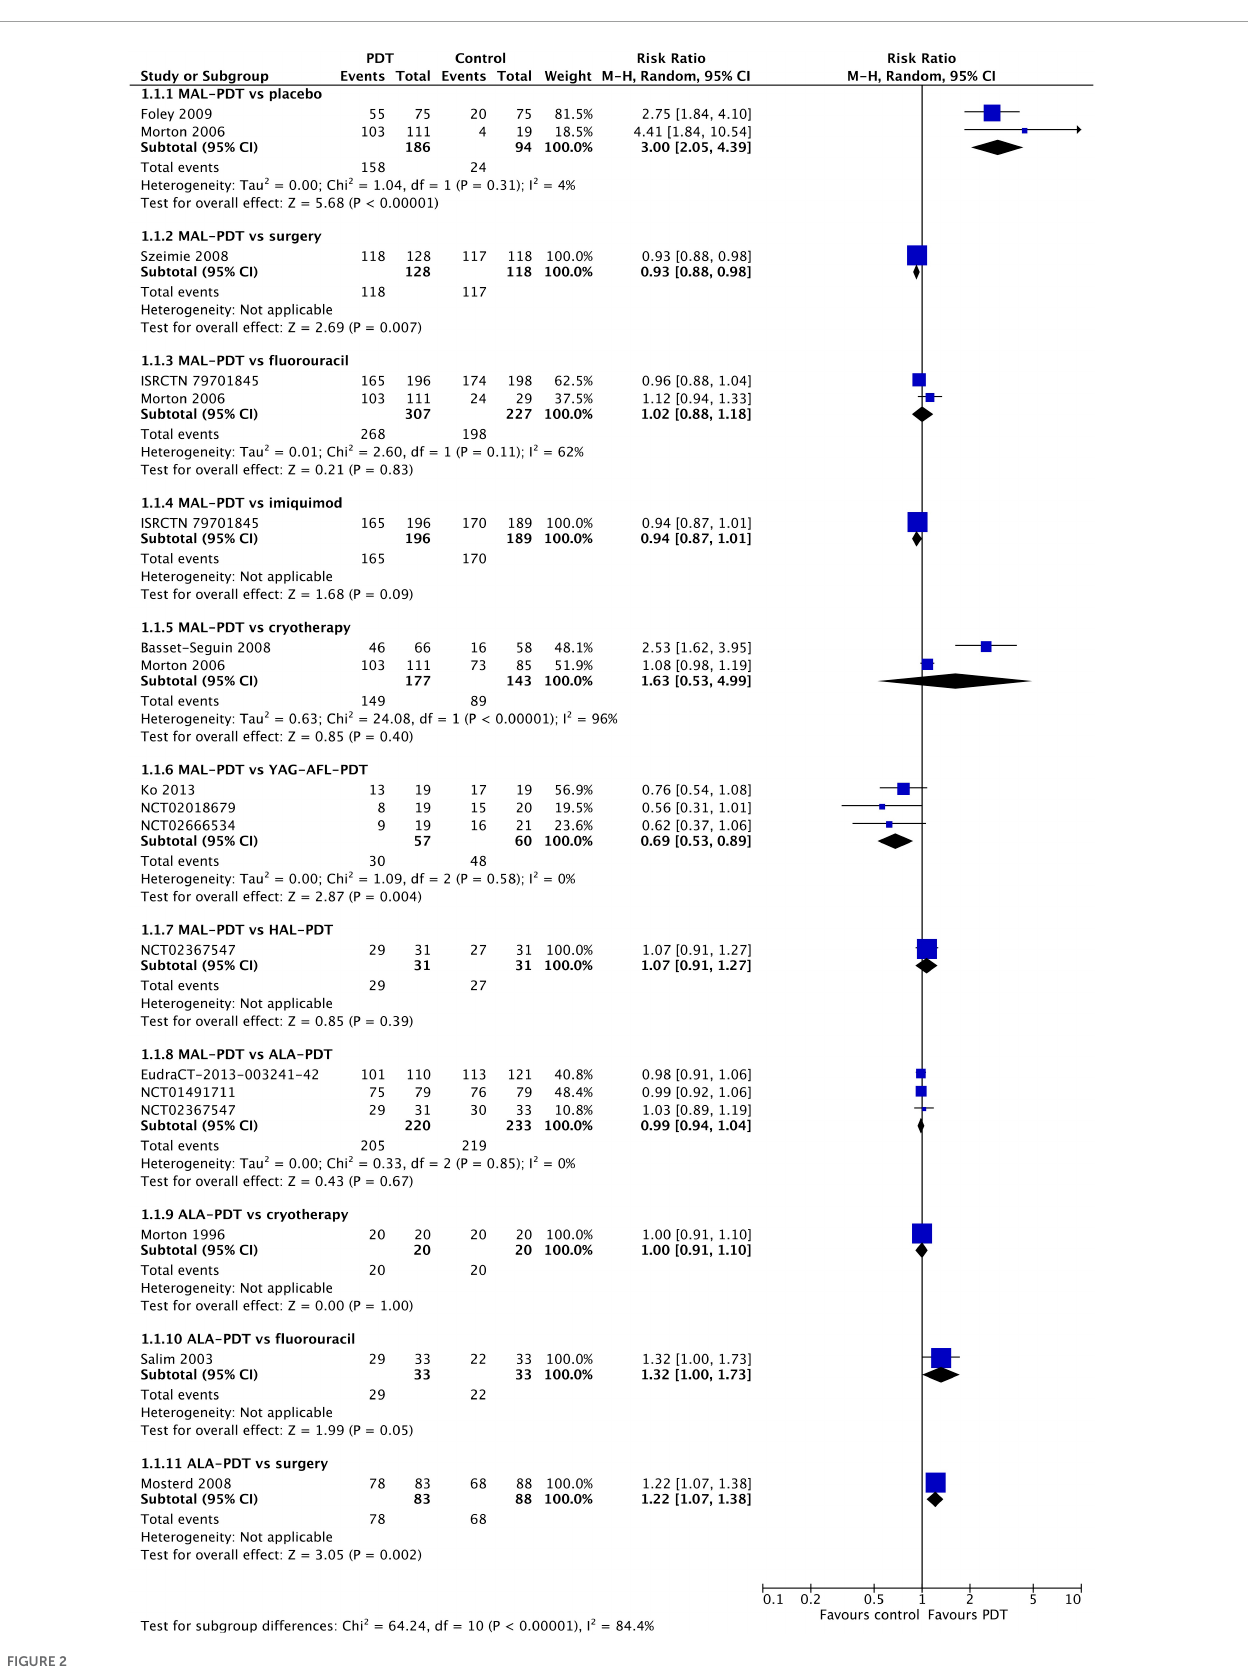
FIGURE2 Meta-analysis of the risk of response at 3 months post-treatment by comparator. Data are risk ratios with 95% confidence